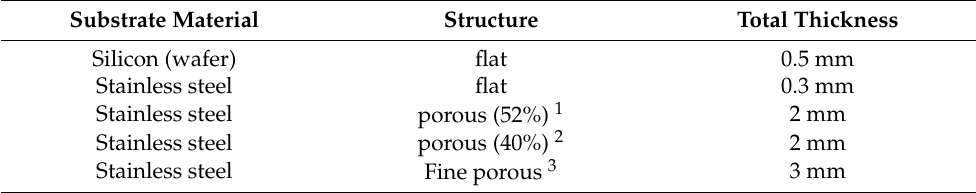
Table 1. Metallic substrates used in this